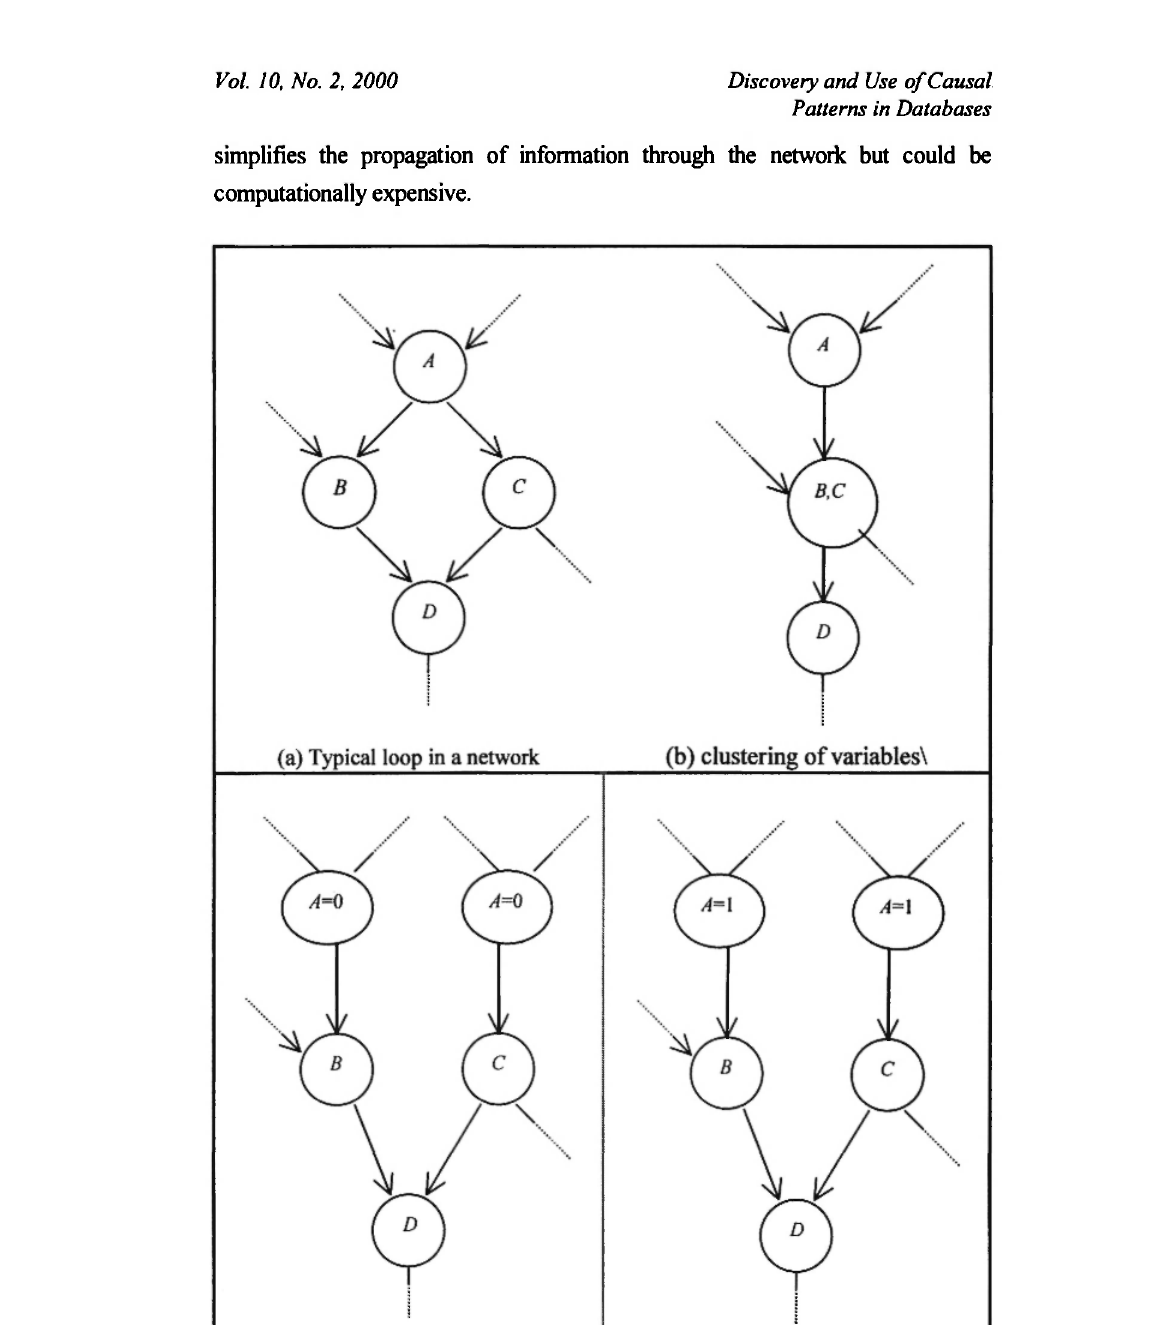
Fig. 9: The clustering and conditioning methods for dealing with non-singly connected causal